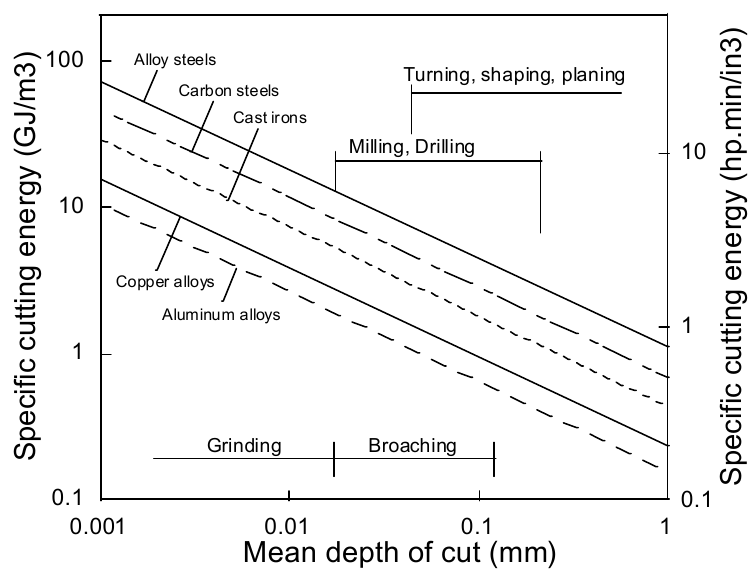
Figure 5. The link between energy consumption, type of machining process and metal category [4].